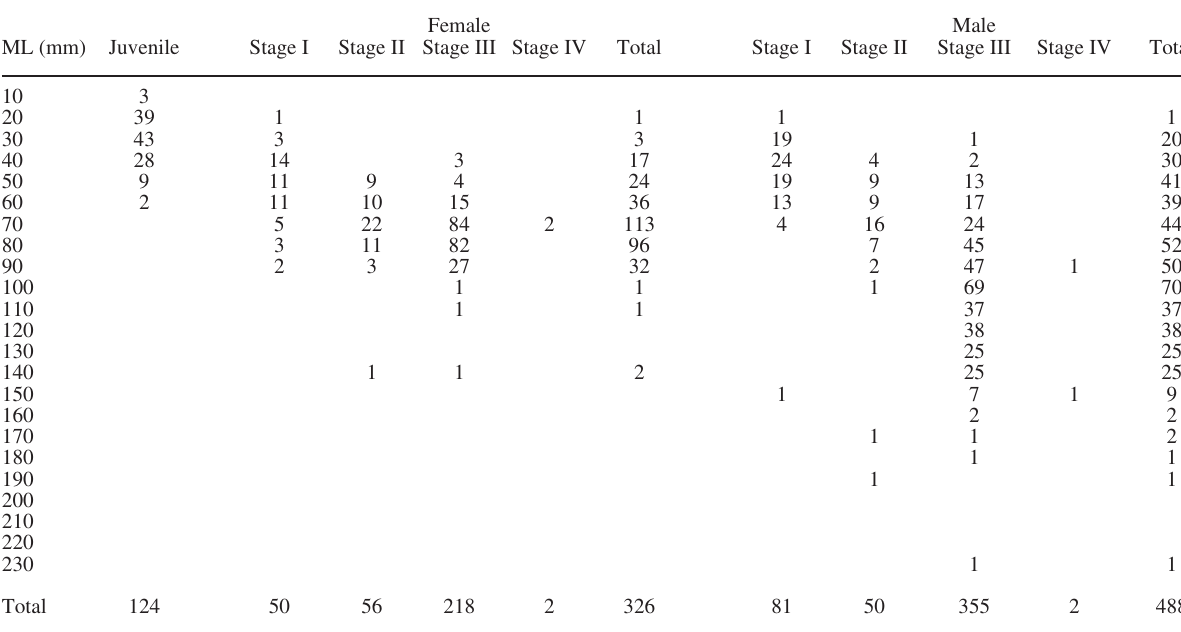
Table 2. – Numbers of Loligo sanpaulensis measured for each class, sex and maturity stage from samples taken by commercial shrimp trawlers in 1999-2000 and 2002-2003 and ground fish cruises of the REVIZEE program. ML = mantle